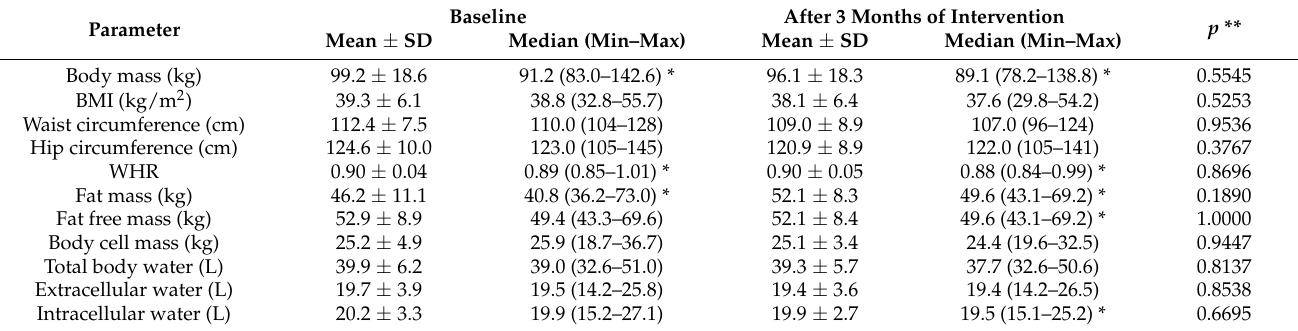
BMI—body mass index; WHR—waist-to-hip ratio; * nonparametric distribution (Shapiro–Wilk test; p ≤ 0.05); ** compared while using t-Student test or Mann–Whitney test (based on